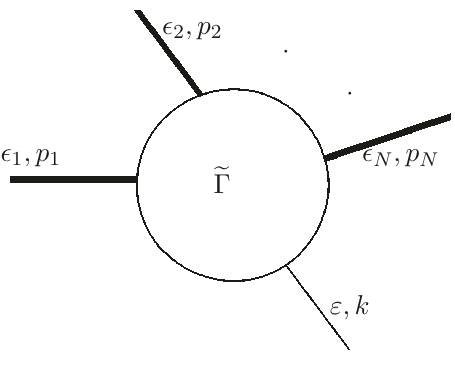
Figure 2 . Source of the subleading contribution to the string loop amplitude with one external soft